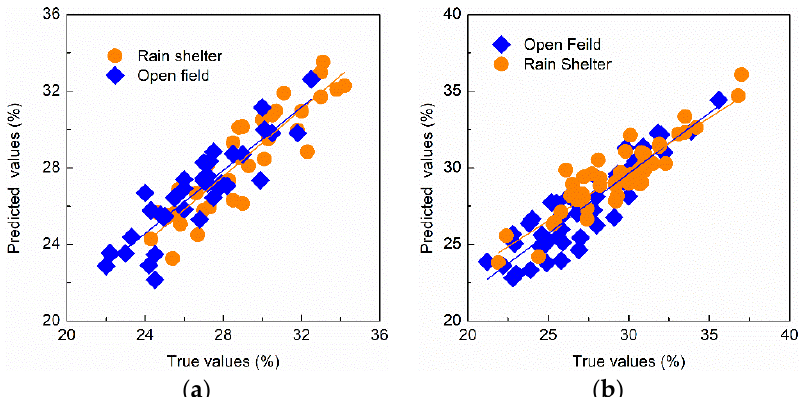
Figure 8. Detection results of SSC after model update using wavelength fusion-Euclidean distance. ( a ) Prediction set results; ( b ) test set results.